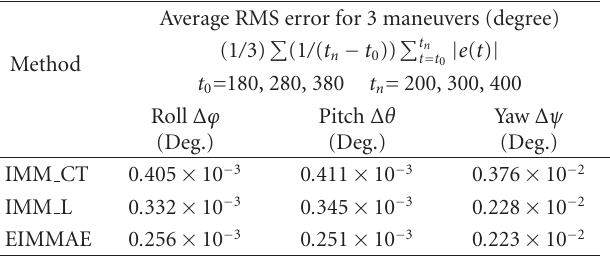
Table 4: Comparing results of EIMMAE structure with IMM L and IMM CT methods.